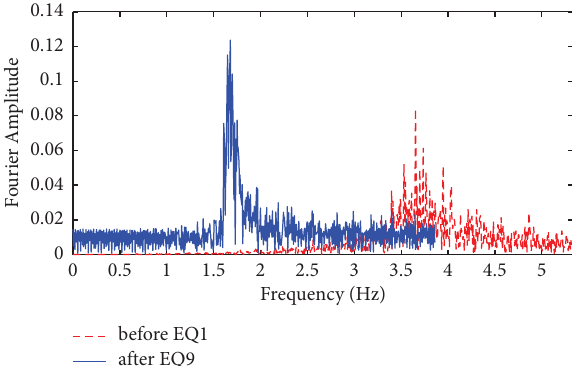
Figure 10: Fourier spectra before frst and after last